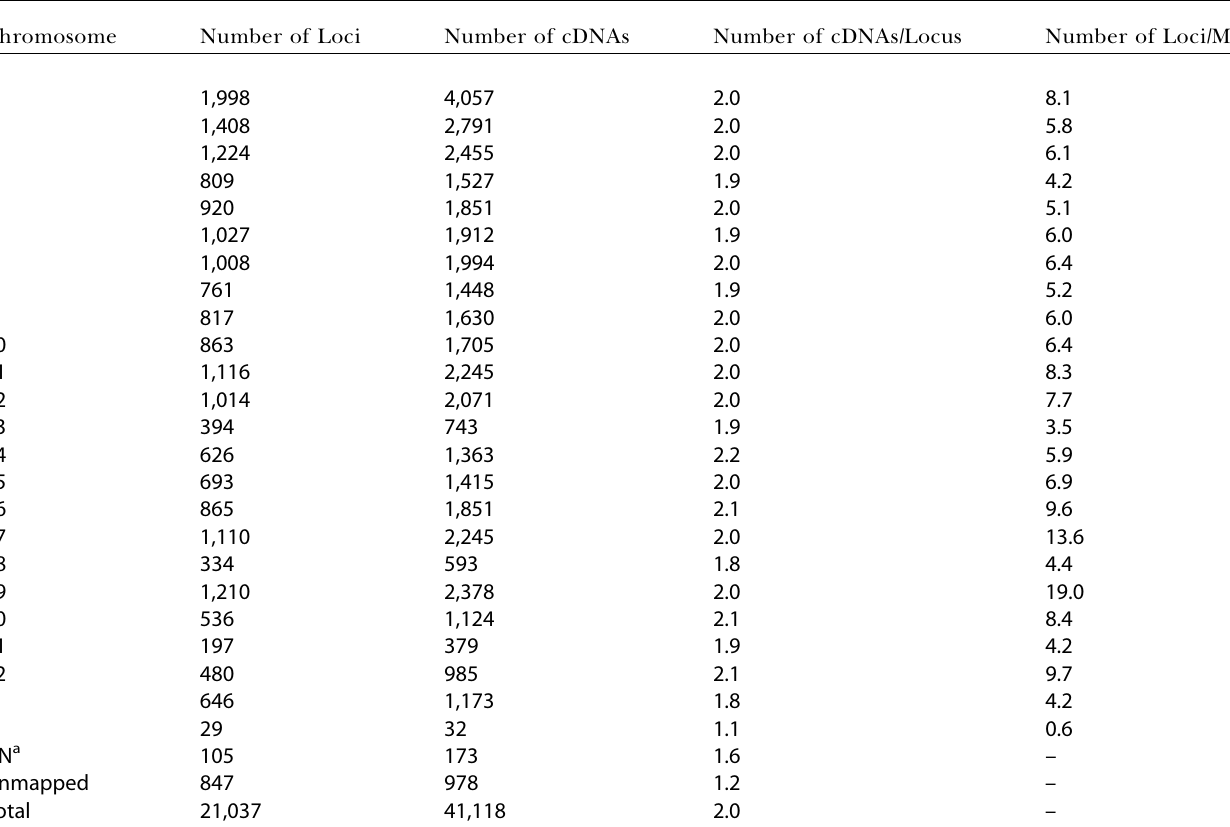
Table 2. The Clustering Results of Human FLcDNAs onto the Human Genome Chromosome